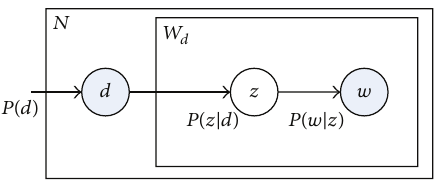
Figure 2: Graph model of pLSA.